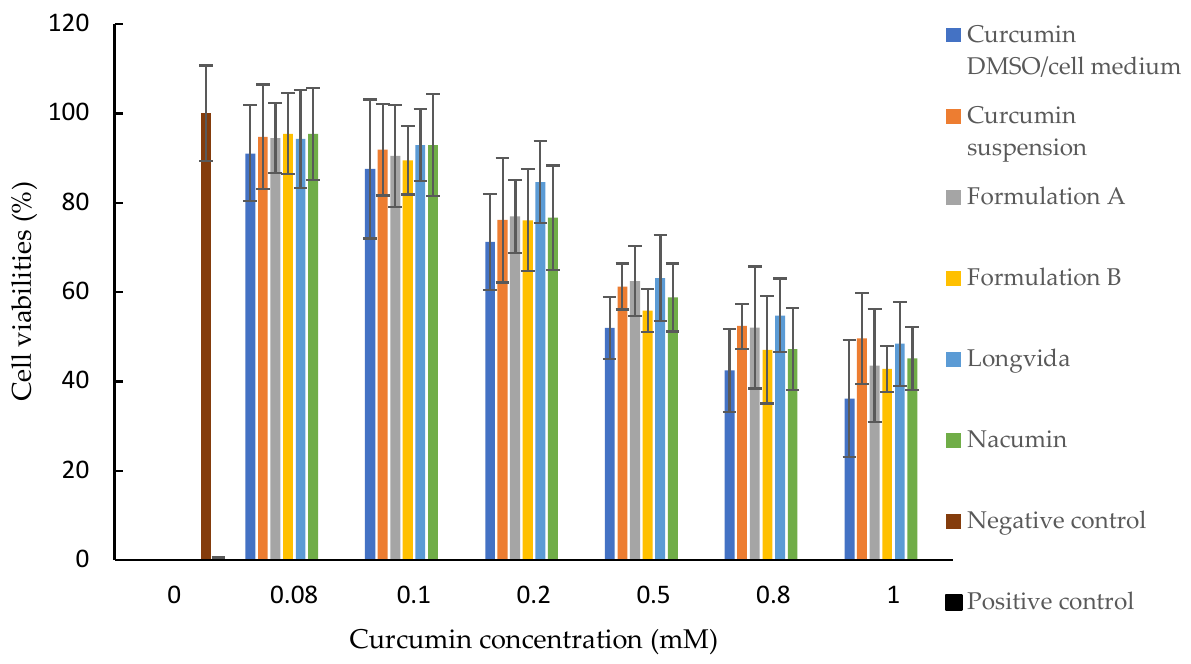
Figure 9. Cell viability (MTT assay) of Caco-2 cells when exposed to each formulation, with equivalent curcumin concentrations from 0.08 to 1 mM ( n = 18, mean ± SD).